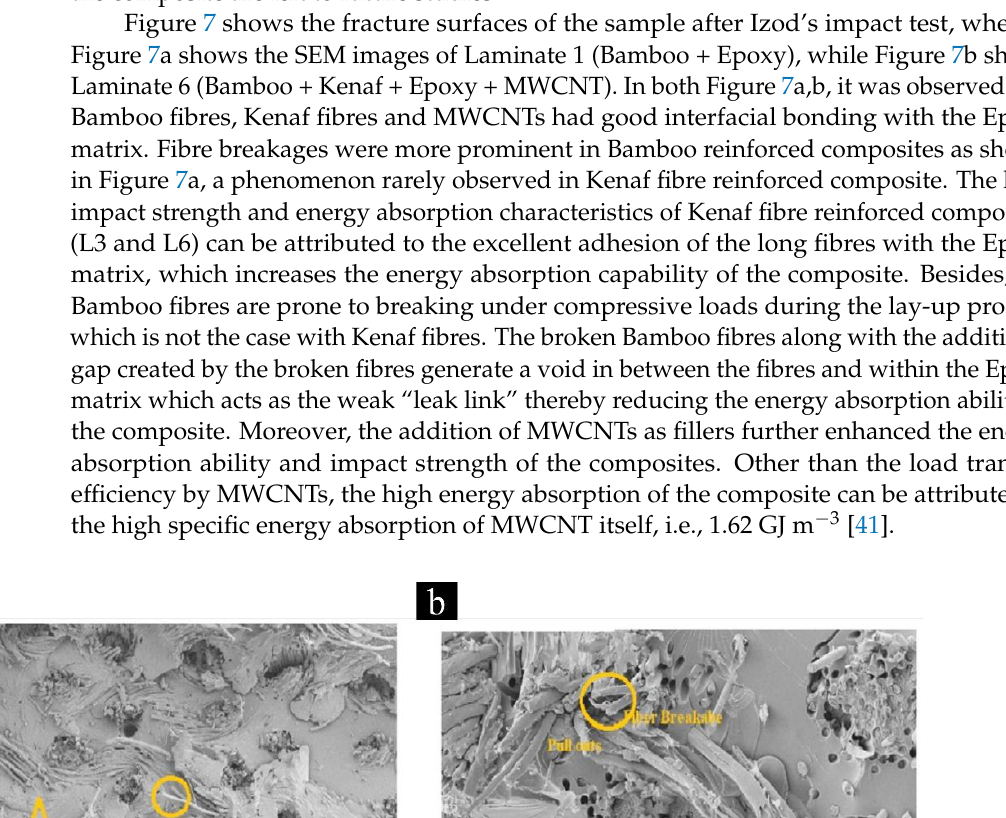
Figure 6. Energy absorbed and impact strength of laminates subjected to Izod’s impact test.